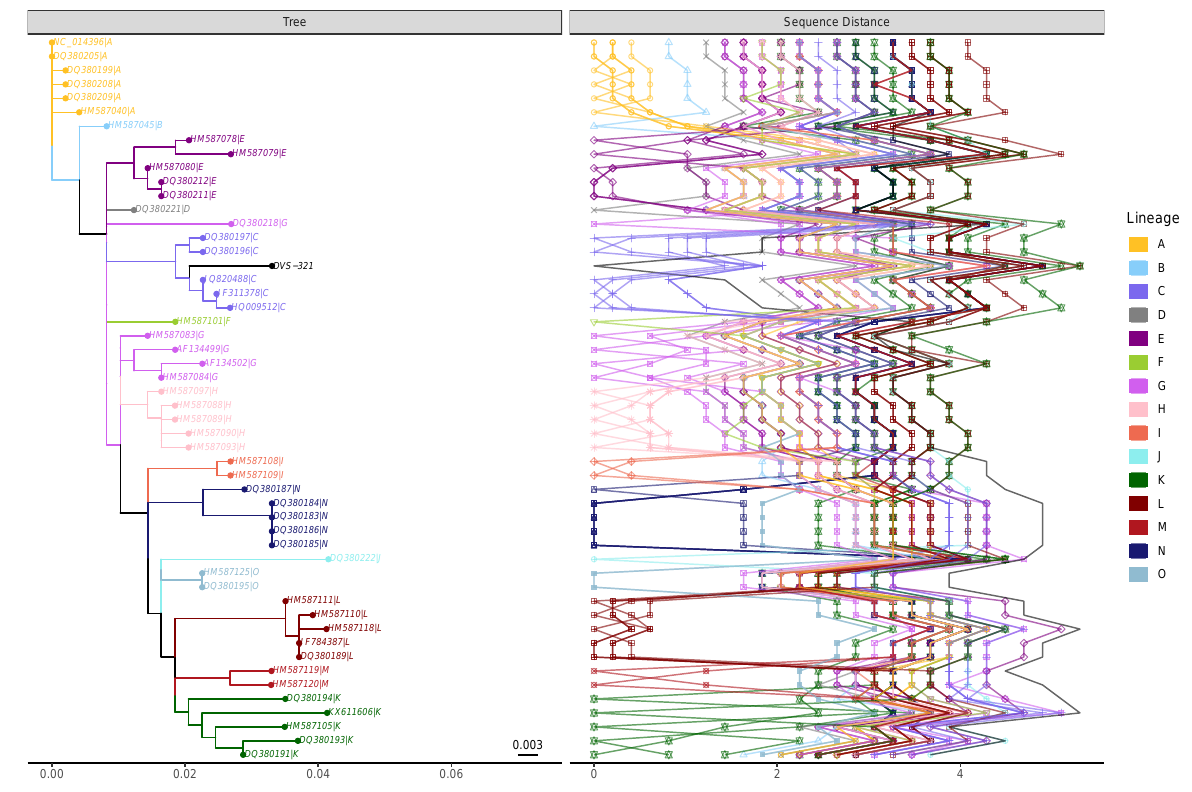
Figure 3. Maximum likelihood phylogenetic tree. Maximum likelihood phylogenetic tree indicating the different clades corresponding to the fifteen major lineages and showing where the query sequence (DVS-321) clusters in the tree. Pairwise distance measure for the different lineages and query samples indicate a genetic diversity, which indicates a maximum diversity of 5% at the nucleotide